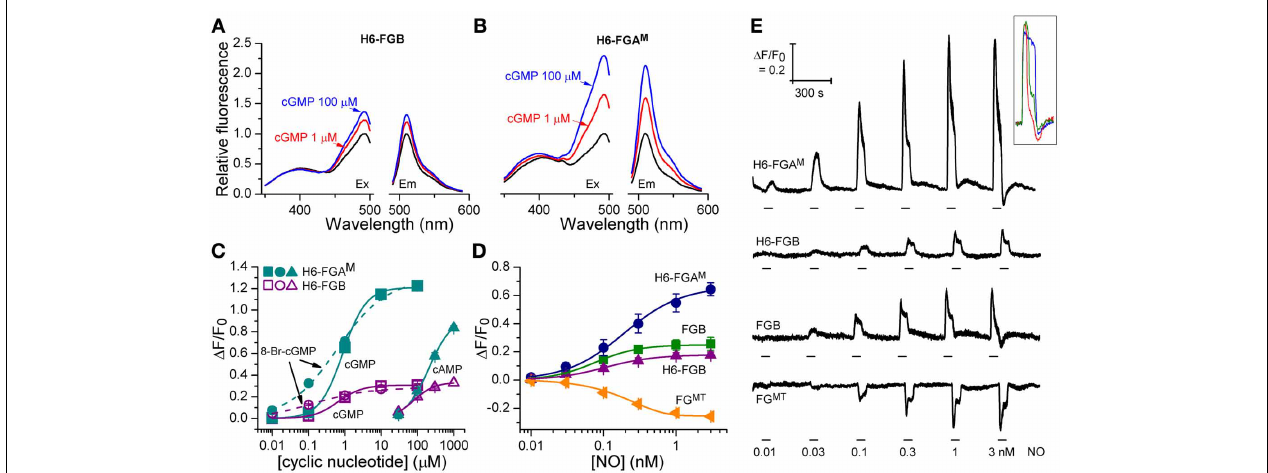
FIGURE 3 | Cyclic nucleotide sensitivity of H6-FGA M and H6-FGB proteins and NO-sensitivity of HEK GC / PDE5 cells expressing selected FlincG variants. (A,B) Sample excitation (left) and emission (right) spectra of H6-FGB (A) and H6-FGA M (B) proteins in the absence (black) and presence of 1 μ M (red) and 100 μ M (blue) cGMP, normalized to the peaks in the absence of cGMP. (C) Cyclic nucleotide concentration-response curves for the two proteins. Points are means of three determinations ± SEM. (D) NO concentration-response curves in HEK GC / PDE5 cells transfected with the indicated FlincG variants ( n = 3–5). (E) Representative recordings of responses to NO